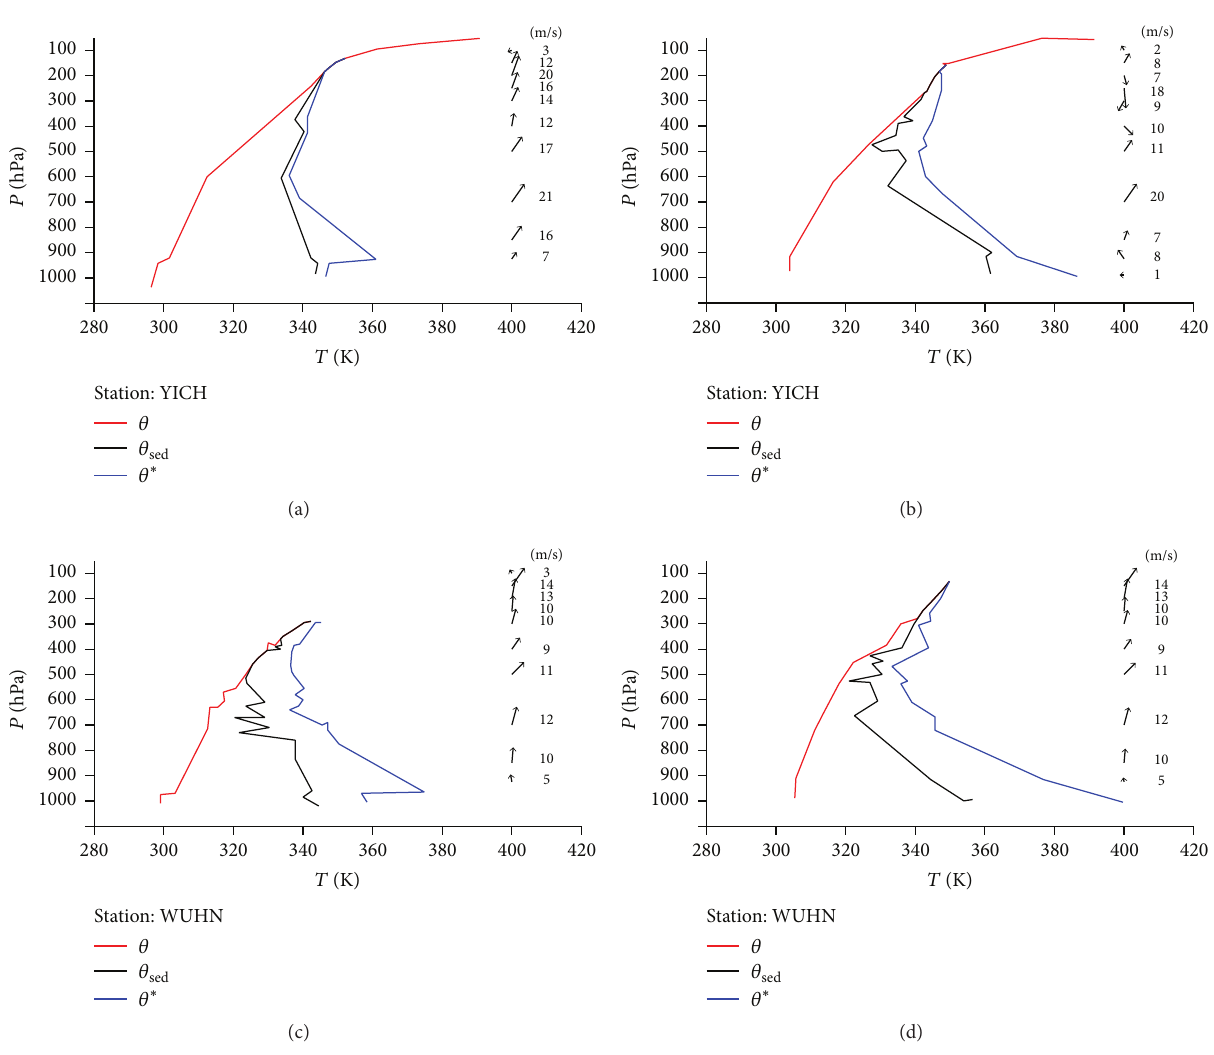
Figure 7: 𝑉 - 3𝜃 distribution conditions: (a) 8:00 a.m. on July 27, 2007, at the YICH station; (b) 8:00 p.m. on July 27, 2007, at the YICH station; (c) 8:00 a.m. on July 27, 2007, at the WUHN station; (d) 8 p.m. on July 27, 2007, at the WUHN station. The red lines are the 𝜃 curves, the green lines are the 𝜃 sed curves, and the blue lines are the 𝜃 ∗